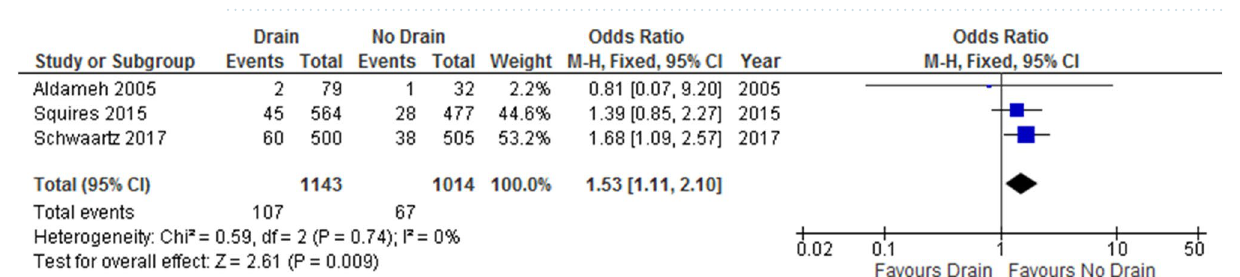
Figure 3. Forest plot of postoperative bleeding.